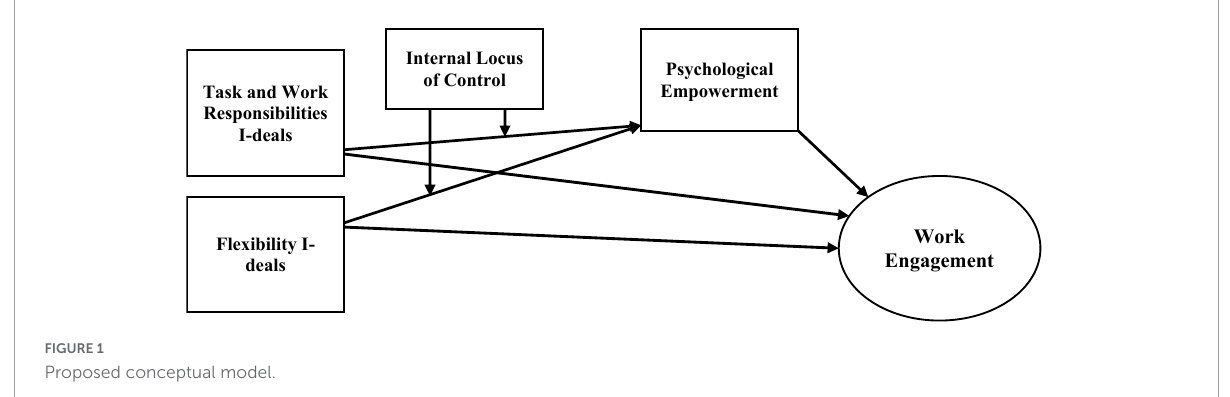
FIGURE1 Proposed conceptual